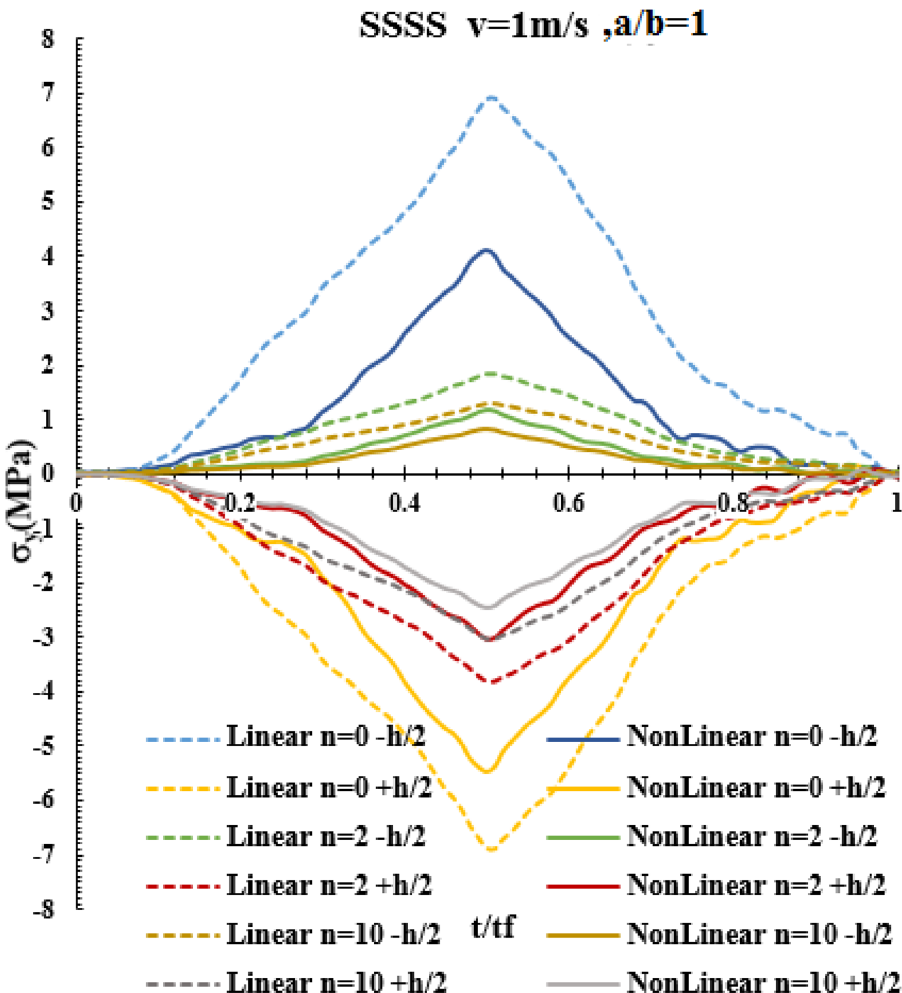
Fig. 24 the effect of material gradient index on transient dis- tribution of 𝜎 yy for center-point of the plate (SSSS, v = 1